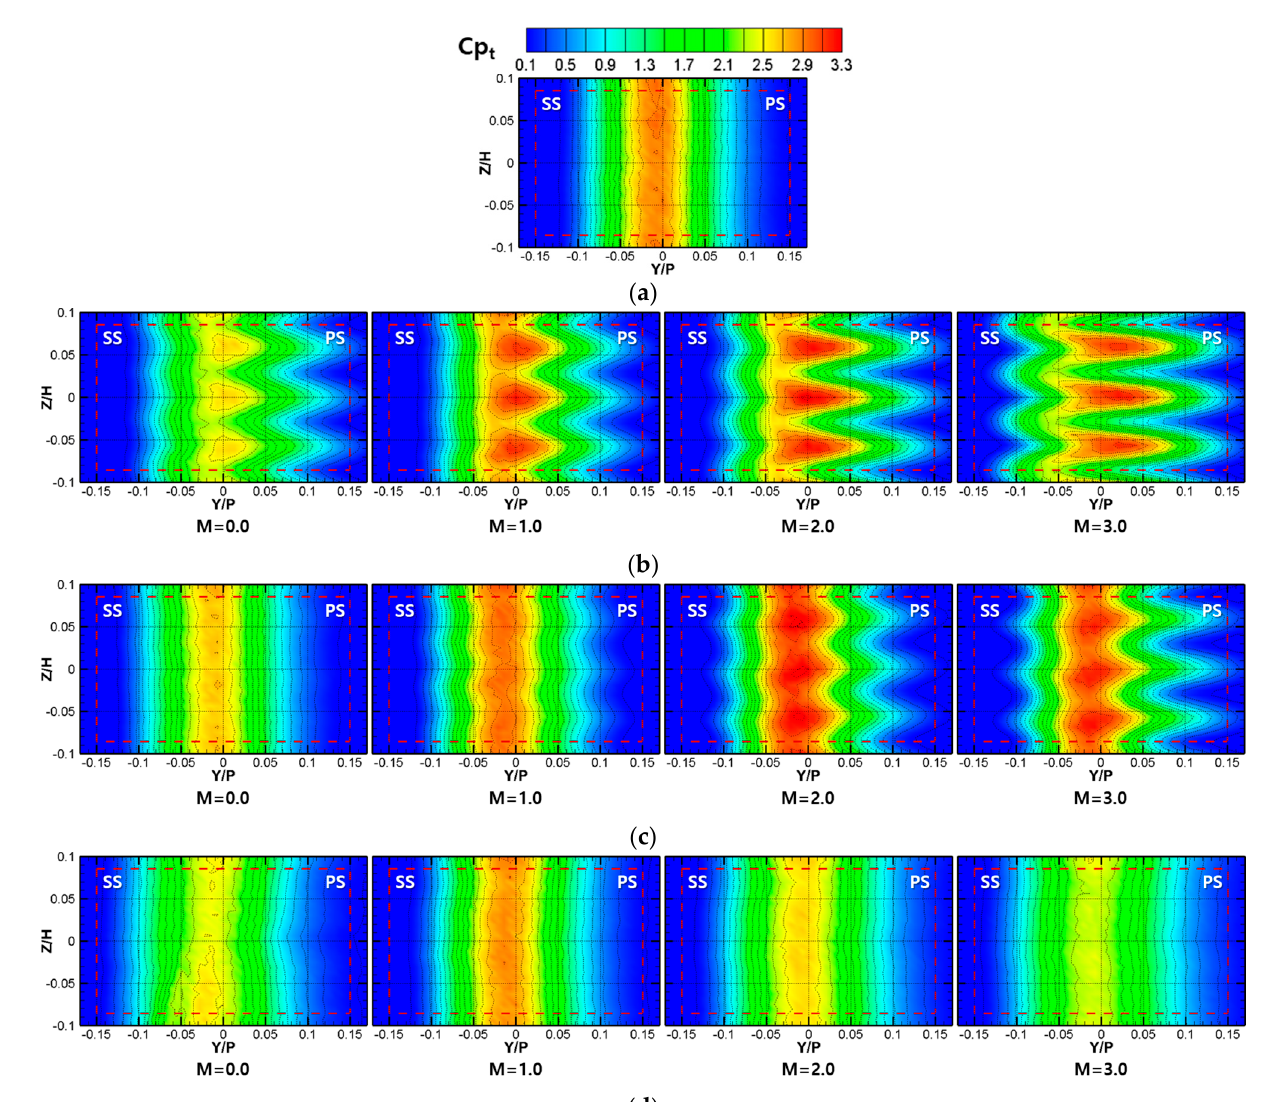
Figure 6. Distribution of the total pressure loss coefficient for various cooling schemes applied to the vane with d (cid:2904)(cid:2889) /T = 1 2.5%: ( a ) solid; ( b ) cutback slot; ( c ) central injection slot; ( d ) pressure side